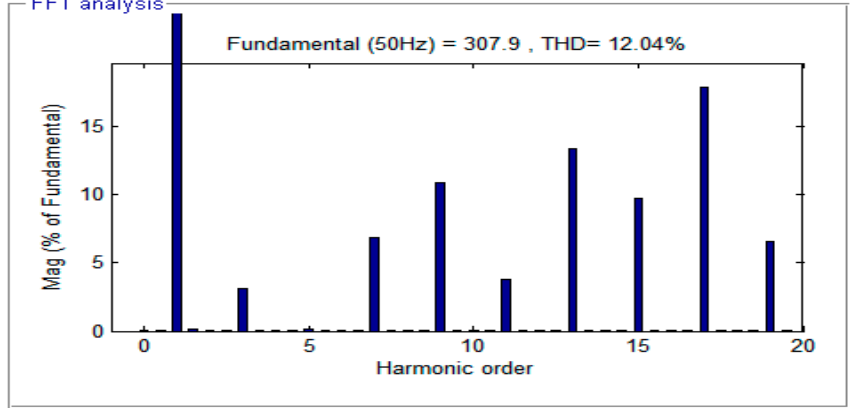
Figure 21. THD analysis of the TLBDCLCHB inverter output using the SWPCAD technique.